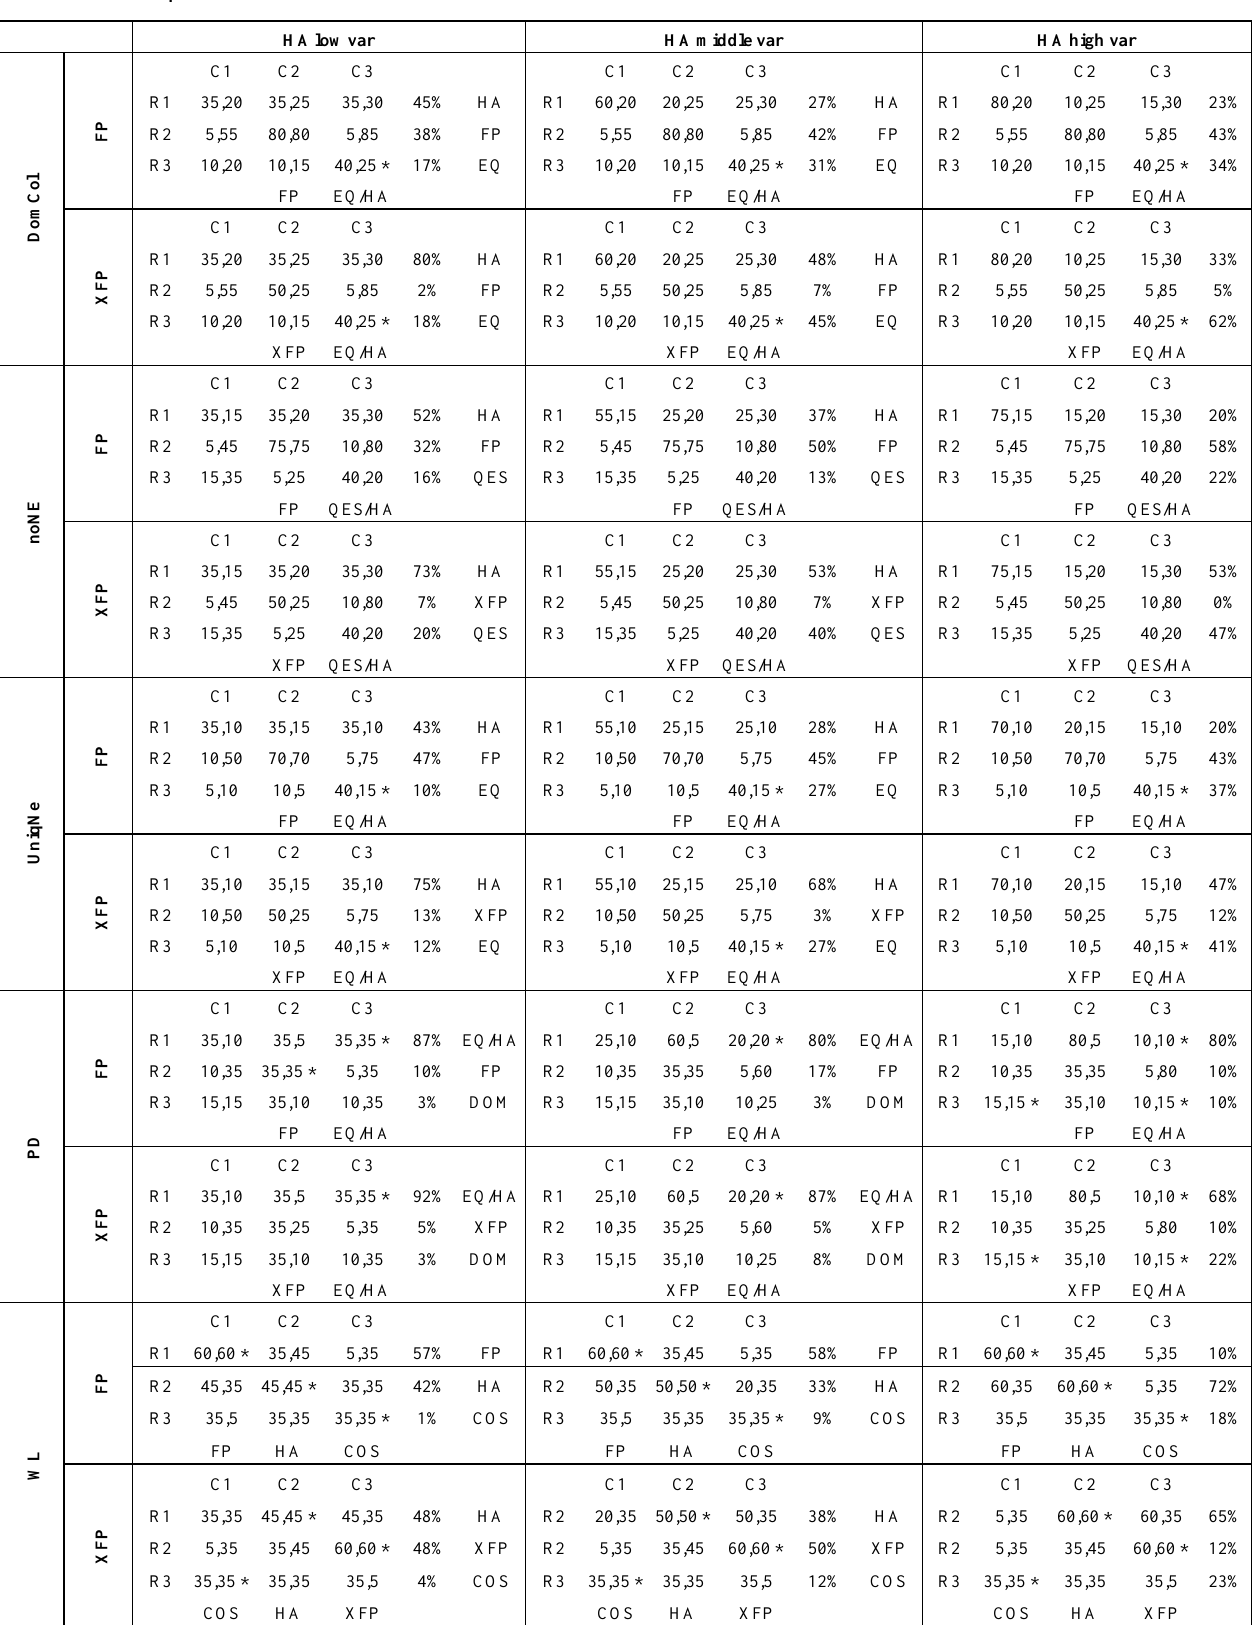
Table 1. The games grouped by type, level of highest average payoff (HA) variance, and presence of Focal Point (FP). * indicates pure strategy Nash Equilibria. Frequency of each row is